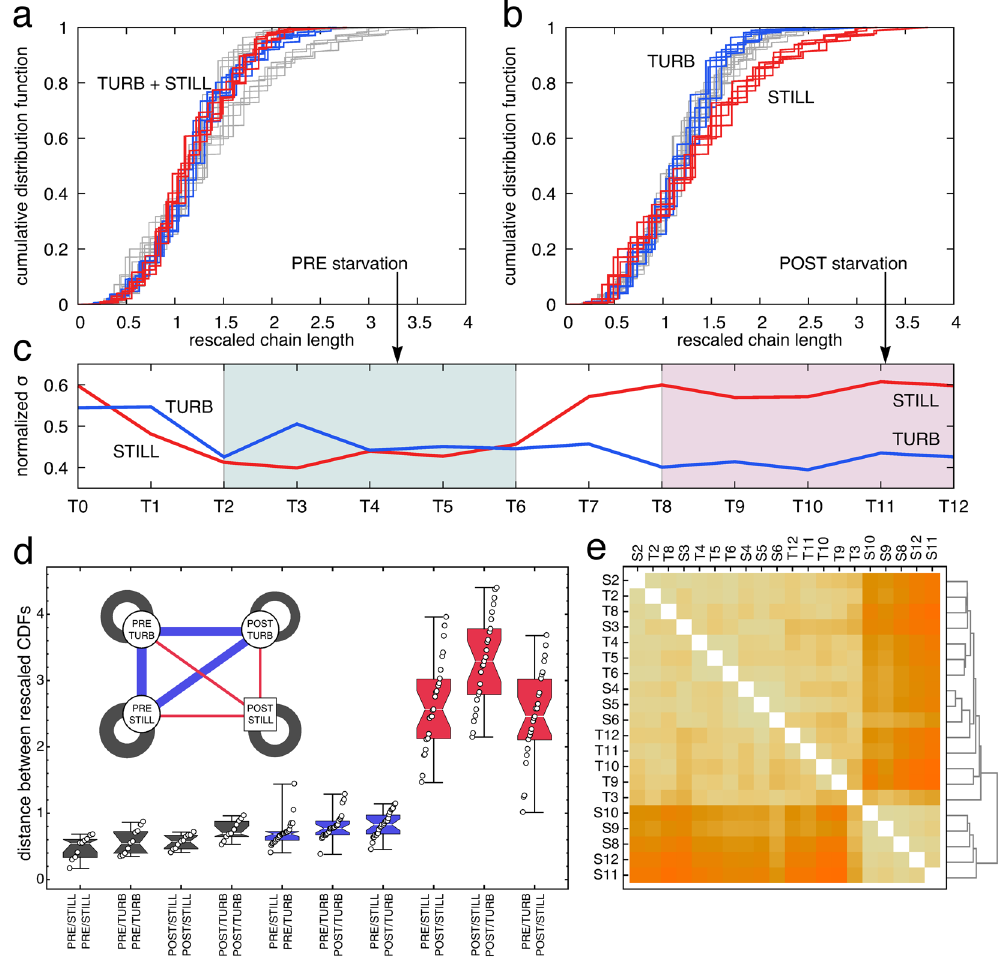
Figure 4. Comparison of chain-length distributions. ( a, b ) Cumulative distribution functions (CDF) rescaled by mean chain length before ( a ) and after ( b ) starvation; turbulent conditions are in blue, still conditions in red. The grey lines in a. are the colored ones in ( b ) and vice-versa. ( c ) The dynamics of the normalized standard deviation for the two conditions throughout the experimental time points (from T0 to T12 on the x-axis). Green and pink colors indicate PRE- and POST-starvation groups used in the analyses. ( d ) The L 2 distance (integral of squared differences) between the cumulative distribution functions for all pairs of CDFs (circles). The four different combinations, PRE- and POST-starvation in still and turbulent conditions (corresponding to the four nodes in the inset), are contrasted pairwise, yielding ten possible combinations (corresponding to the groupings on the x-axis and to the links in the inset, whose width is inversely proportional to the average distance). Intra- combination distances (dark grey in figure) are smaller than inter-combination distances involving POST-still (red in figure), but comparable to the other inter-combination distances (blue in Figure). ( e ) Hierarchical clustering based on the L 2 distances (darker shades correspond to larger distances) isolates the four POST- starvation CDFs in still conditions (S8–S12). The other cluster groups S2–S8 (pre-starvation in still) and all the turbulent CDFs (T2–T12). Clustering does not discern the POST-starvation CDFs in turbulent conditions